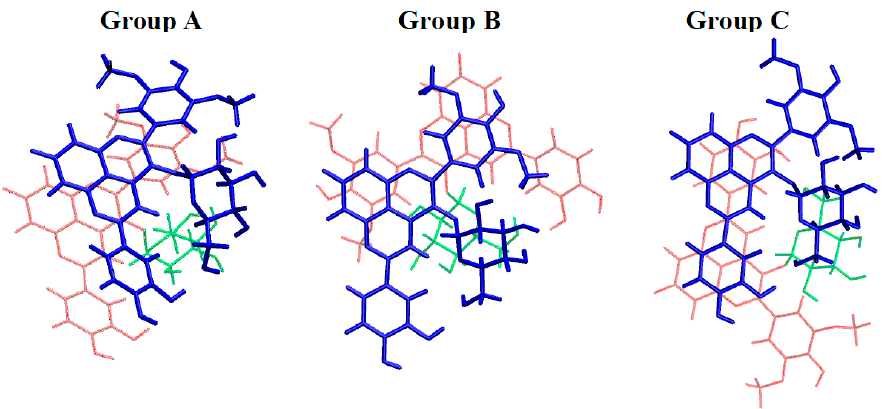
Figure 8. Three representative conformers of PA1 self-association complexes of the three representative groups, exhibiting geometrical similarities: Group ( A ) interactions between A-, C-, and D-rings of both PA1 fragments; Group ( B ) interactions between A-, C-, and D-rings of one PA1 and the B-ring of the other PA1; and Group ( C ) interactions between A-, C-, and D-rings of one PA1 with the E-ring of the other PA1. For clarity purpose, one PA1 partner is in blue, whereas the other is both in red (pyranoanthocyanidin moiety) and in green (sugar moiety). Three types of conformers could be distinguished: Group A, exhibiting interactions between A-, C-, and D-rings of both PA1 units; Group B, exhibiting interactions between A-, C-, and D-rings of one PA1 and the B-ring of the other PA1; Group C, exhibiting interactions between A-, C-, and D-rings of one PA1 with the E-ring of the other PA1. In each group, electrostatic and H-bonding